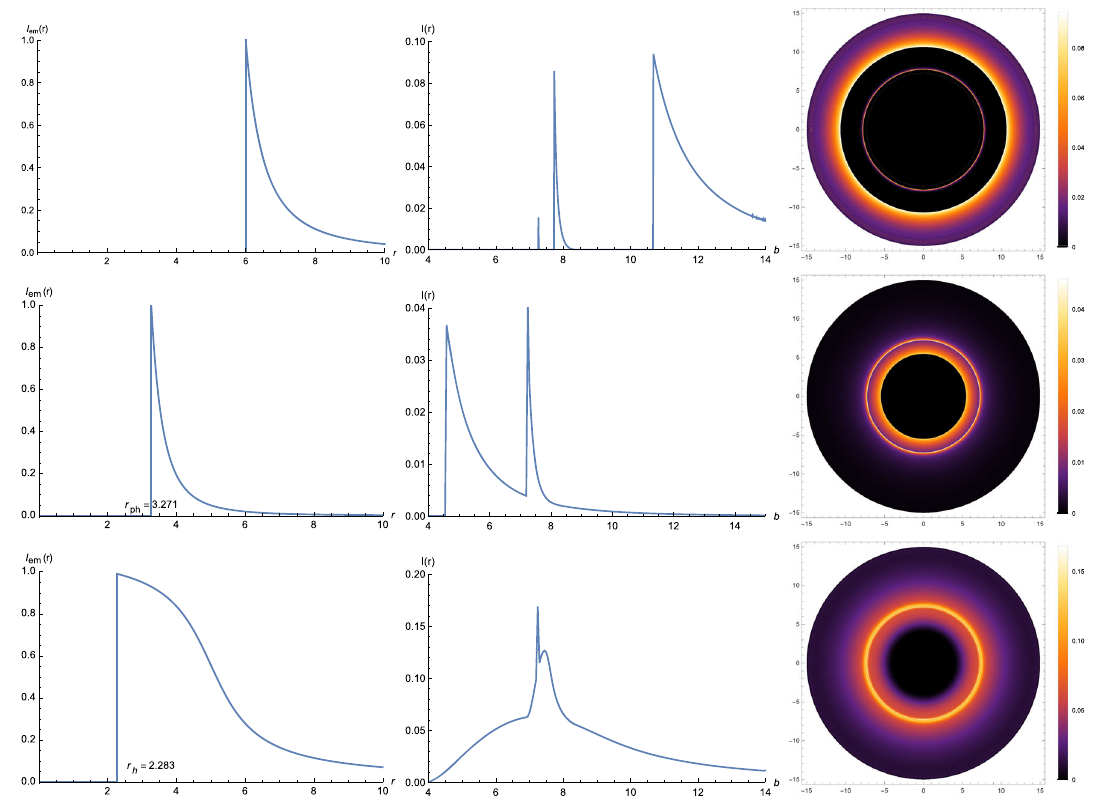
the observed emission I ( r ) as a function of the impact parameter b . The right column shows the two-dimensional density plots of the observed emission I ( r ) . The profiles are similar to those of w = − 0 . 5 in Fig.